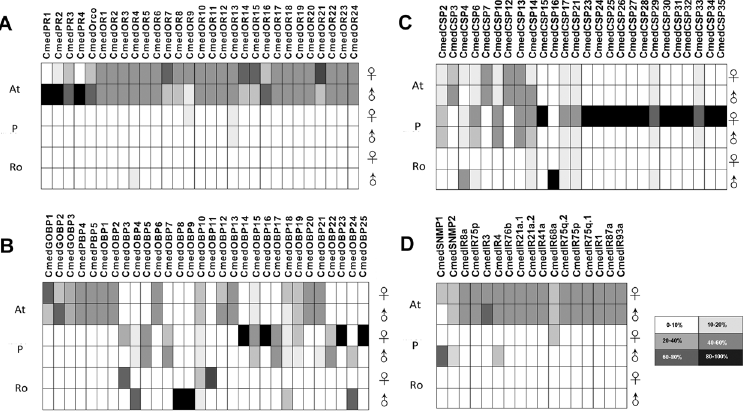
Fig 8. Comparison of OBP, OR, CSPs, SNMPs, and IRs expression based on FPKM values in male and female adult C. medinalis chemosensory tissues. (A) The common set of ORs expressed in each tissue in both males and females. (B) The common set of OBPs expressed in each tissue in both males and females. (C) The common set of CSPs expressed in each tissue in both males and females. (D) The common set of ORs expressed in each tissue in both males and females. The antennal libraries included both antennae, the protarsus libraries included the tarsus of six legs, and the reproductive organ included the last three abdominal sections.